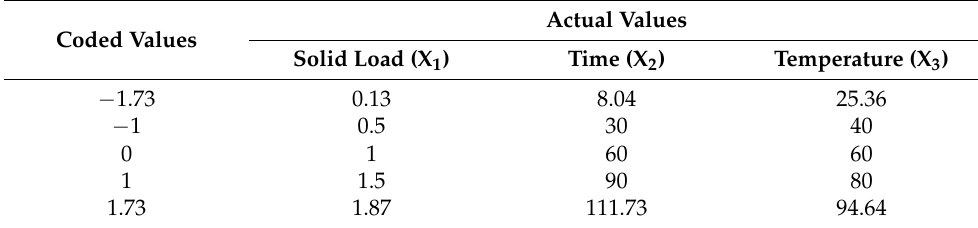
Table 1. Coded and actual values of independent